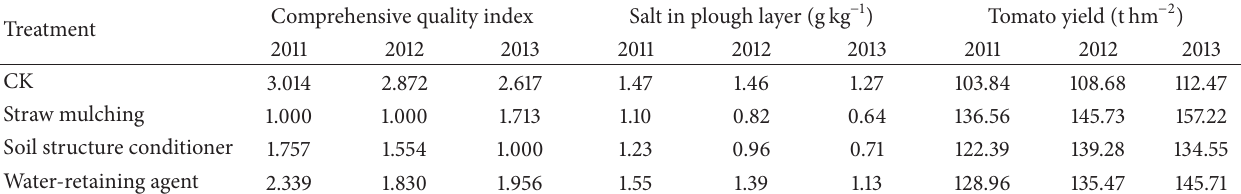
Table 5: Comprehensive quality index, soil salt content in plough layer, and tomato yield.